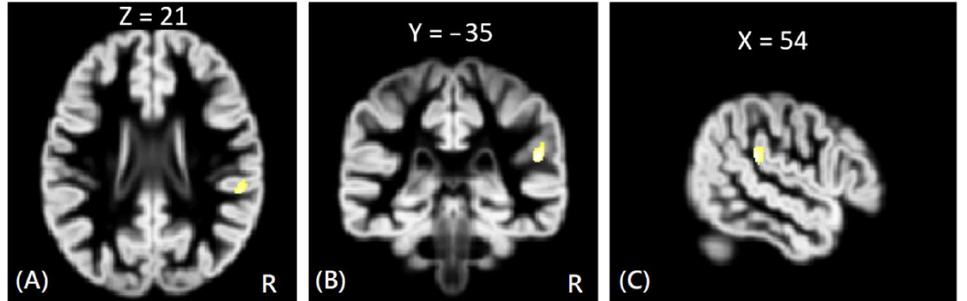
Figure 1. The VBM analysis of GM volume between the NV and HC groups. The yellow-white color indicates the significantly increased GM volumes in the NV group HC in the right superior temporal gyrus. The images are shown in axial ( A ), coronal ( B ), and sagittal views ( C ).